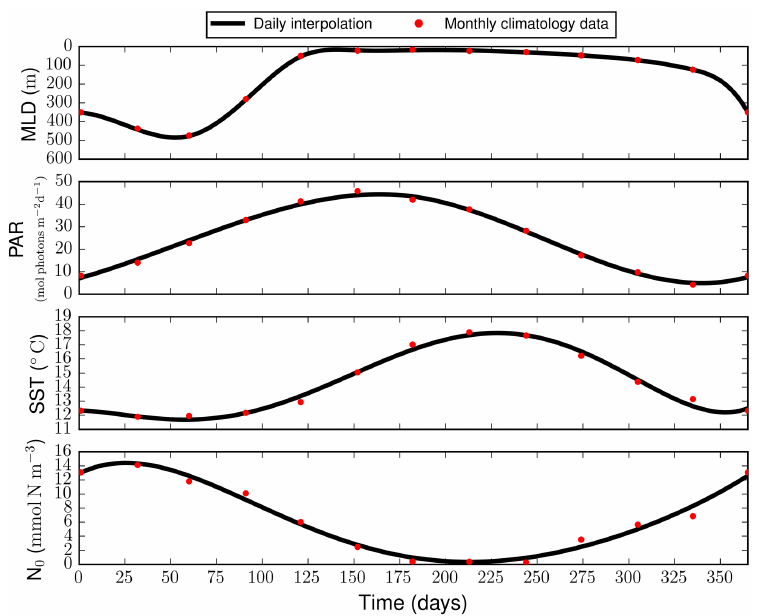
Figure 2. Temporal variation of the environmental variables. The monthly climatology data (red dots) are spatially averaged over the test location (square boxes in Fig. 1). The interpolation (continuous line) is obtained with a third- (MLD and PAR) and a fifth-order (SST and N 0 ) polynomial. Table 2. Computation time in seconds for the full model with 10 and 100 morphotypes and the four variants of the aggregate model. System Full 10 Full 100 Unsustained Fixed Trait diffusion